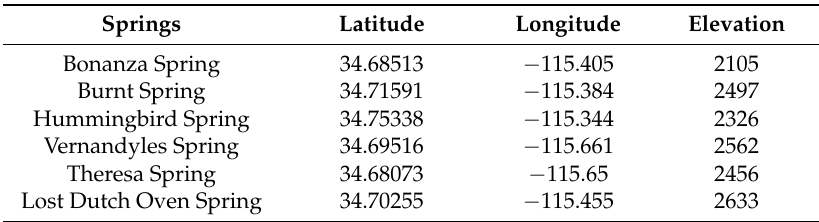
Figure 1. Location of the springs investigated within the Mojave Trails National Monument. Also shown are the location of the closest weather stations where local precipitation has been recorded. Table 1. Spring locations and